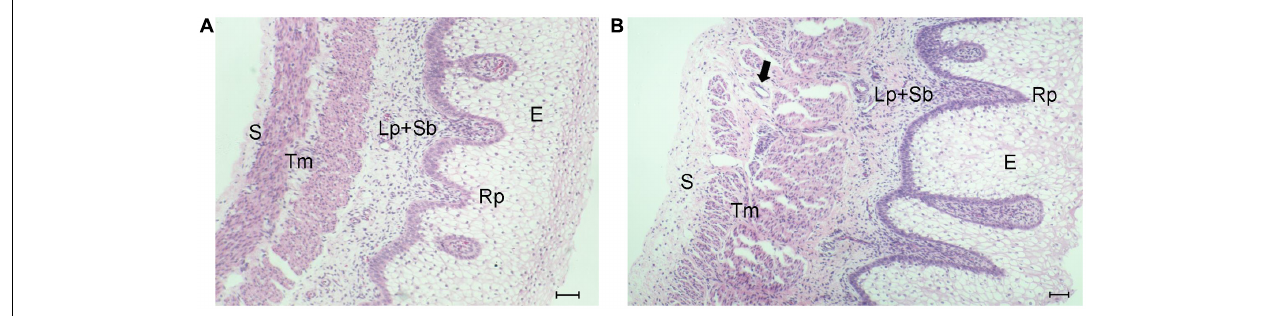
FIGURE 1 | Histological observation of embryonic goat rumen tissues. The wall is composed of four layers: epithelium (E), lamina propria and submucosa (Lp + Sb), tunica muscularis (Tm), and serosa (S). (A) Photomicrograph of rumen wall at E60. (B) Photomicrograph of rumen wall at E135. The arrow indicates the blood vessel. Bar, 100 µ